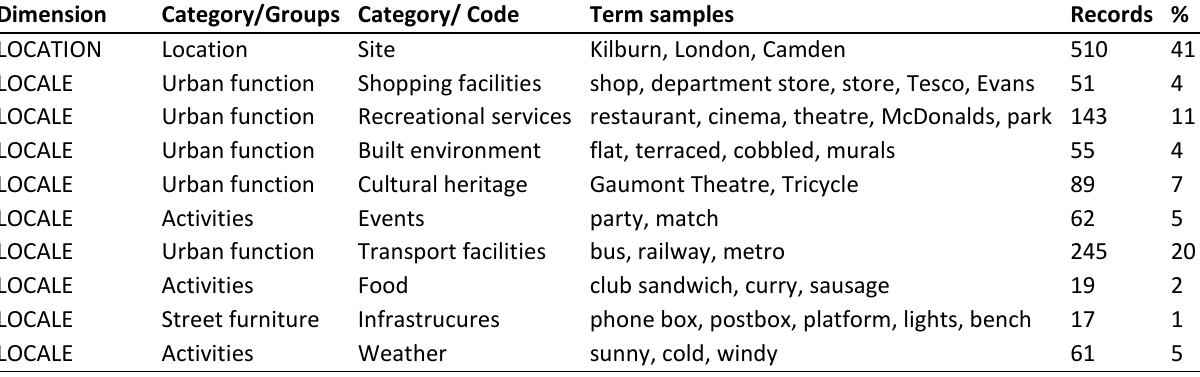
Table 1. Distribution of Tweet and Flickr photos’ records in the conceptual categories.